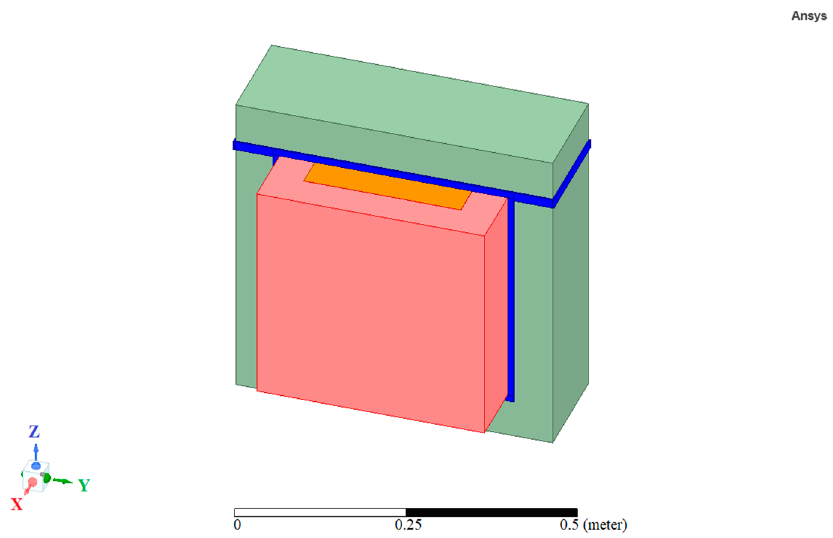
Figure 5. Transformer model with cladding of HTS bulk material over air gaps (the BSST model).